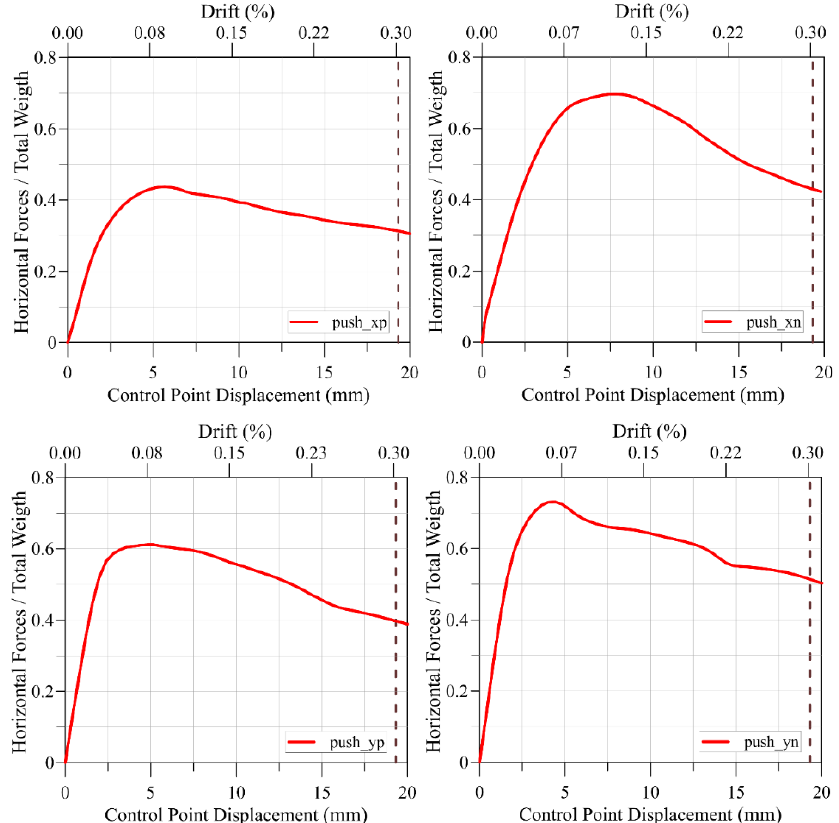
Figure 16. Pushover analysis graphs of the main structure.